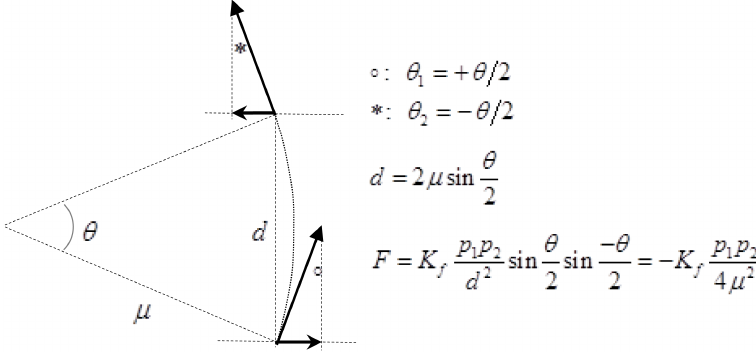
Fig. 2. Intra-circulation